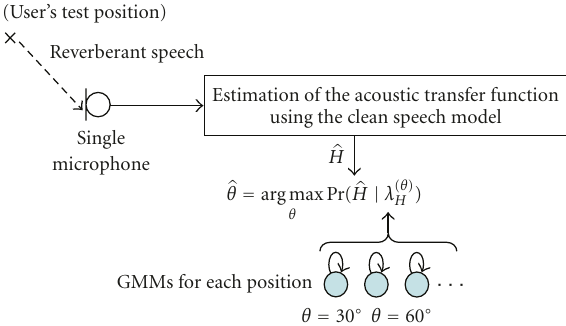
Figure 2: Estimation of talker localization based on discrimination of the acoustic transfer